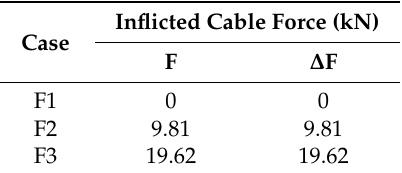
Table 7. Test cases of tension forces in the cable structure.